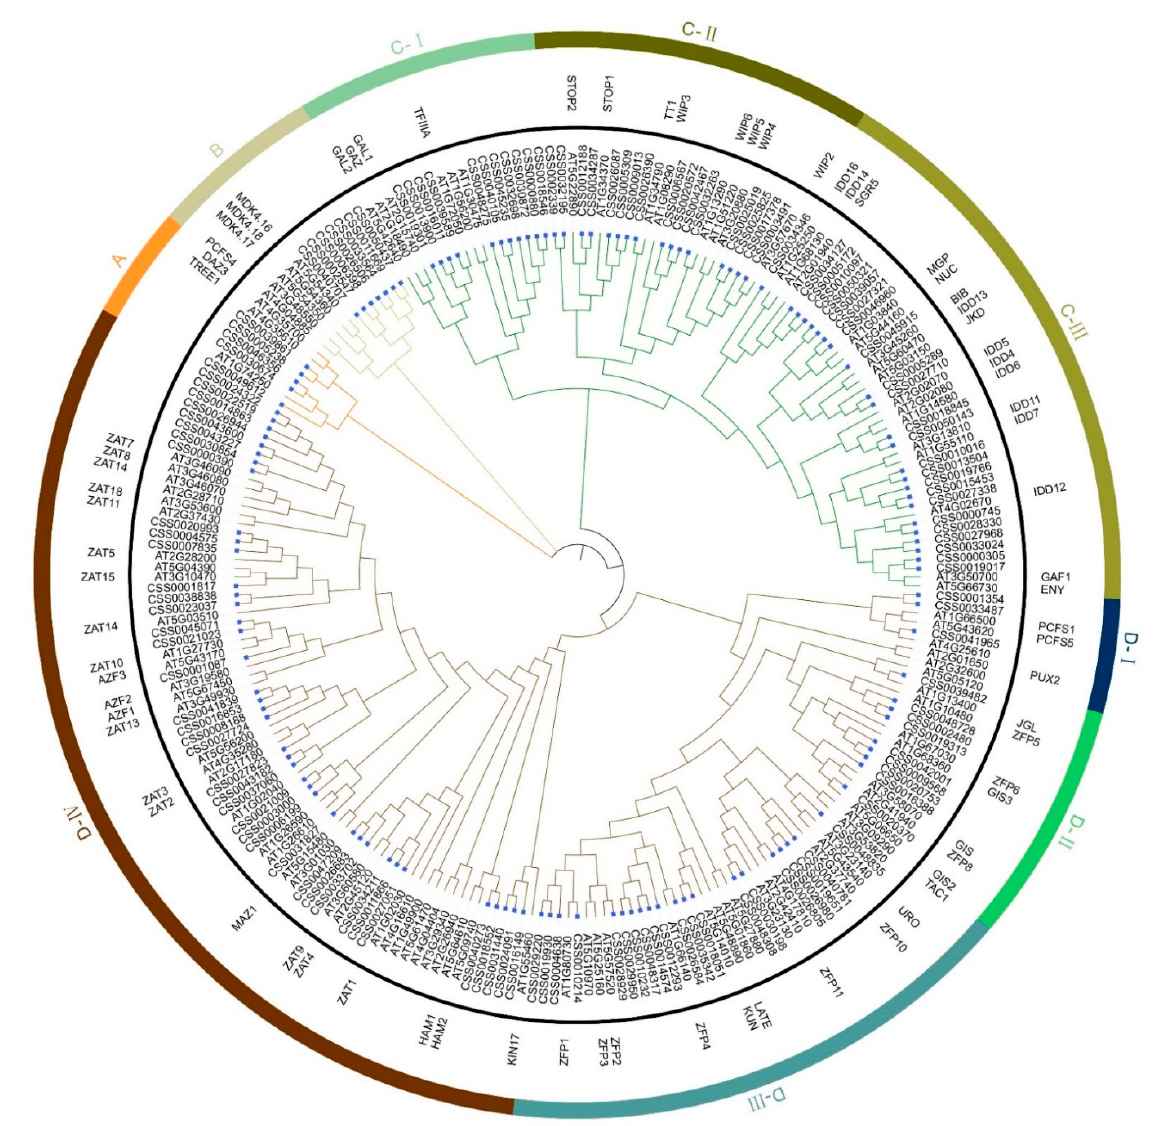
Figure 1. Phylogenetic classification of C2H2-Zinc Finger (C2H2-ZFP) proteins between Arabidopsis thaliana and Camellia sinensis . The phylogenetic tree was built with the maximum likelihood method for 1000 times bootstraps. Four subclasses were marked with arcs outside the circular tree using different colors. The blue rectangle represents CsC2H2-ZFPs from C. sinensis .